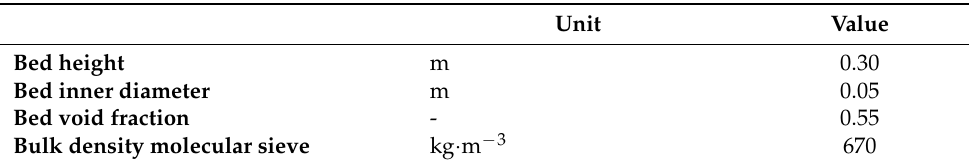
Table 4. Adsorption bed specifications